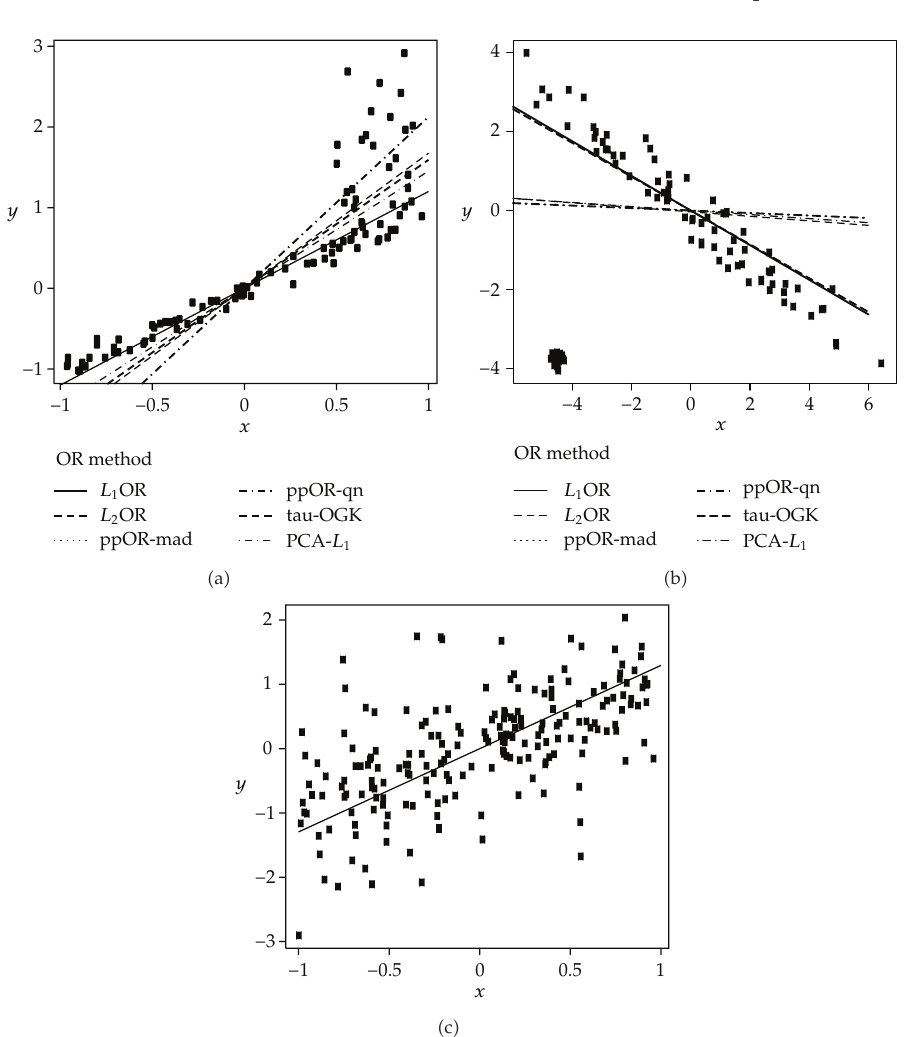
Figure 3: Examples of data sets used in simulation experiments and fitted models: (cid:2) a (cid:3) a data set with vertical outliers generated using parameters m (cid:8) 10 and C (cid:8) 25, (cid:2) b (cid:3) a data set with clustered leverage outliers with n (cid:8) 100 and generated using (cid:3) (cid:8) 0 . 25, and (cid:2) c (cid:3) a data set with errors in both variables sampled from a Laplace distribution with n (cid:8)